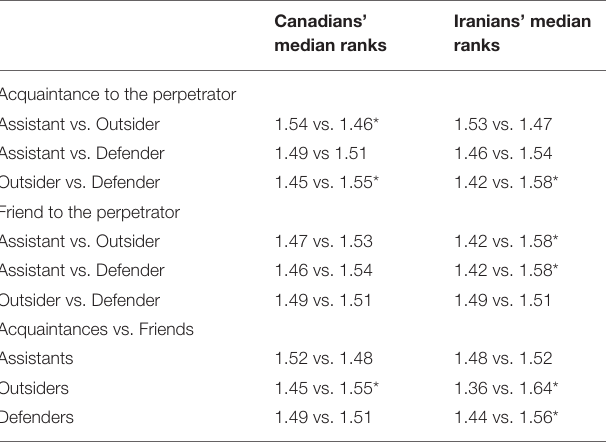
TABLE 2 | Summary of comparisons (and median ranks) of moral emotion attributions to bystander behavior according to country and the bystander’s relationship with the perpetrator.